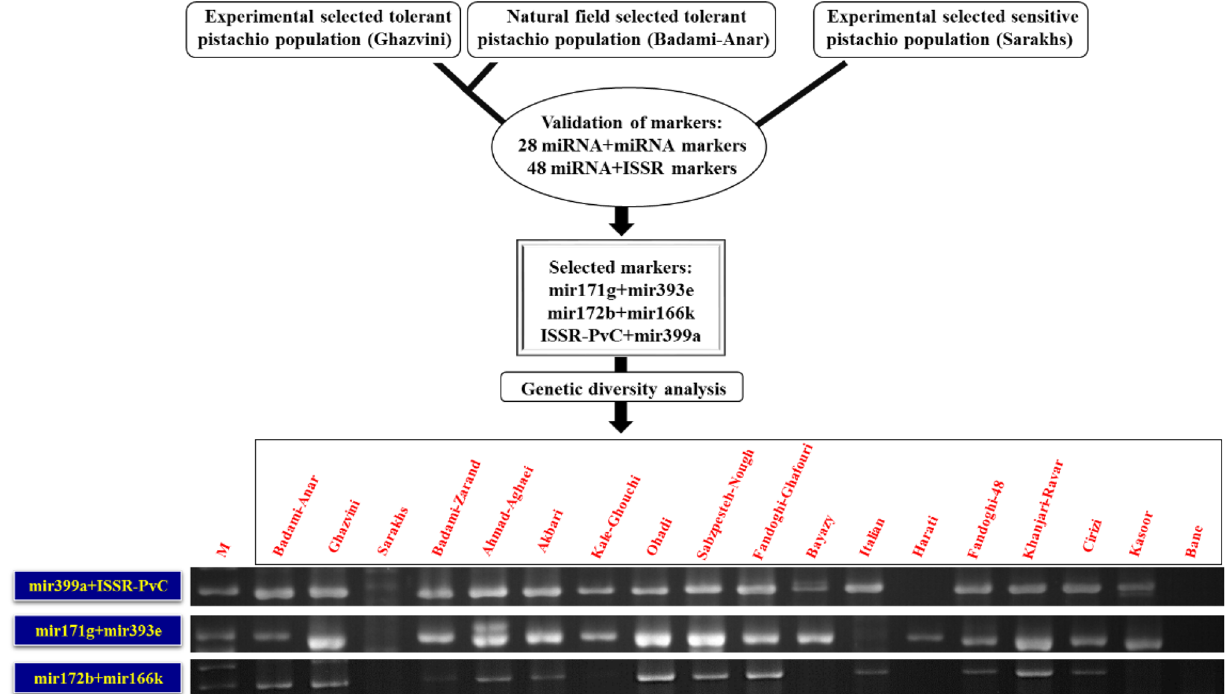
Figure 9. General flowchart of the pipeline used to BSA for MAS in P. vera . M: GeneRuler 100 bp Plus DNA Ladder. Full-length gels are presented in Supplementary Figure S3.